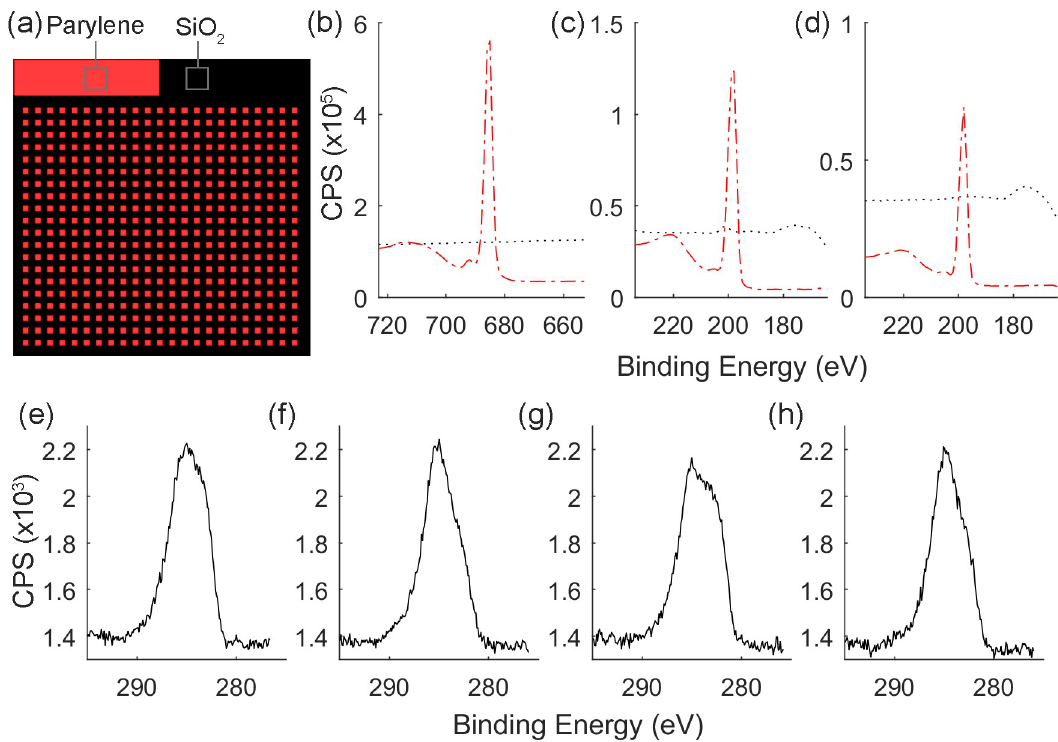
Fig 3. XPS analysis of parylene/SiO 2 substrates that were manufactured by femtosecond laser ablation. (a) Schematic of the parylene/SiO 2 substrates indicating the location of spectra collection. (b) Fluorine 1s spectra of parylene-HT (Red, dashed line), and ablated SiO 2 (Black, dotted line), (c) Chlorine 2p spectra of parylene-D (Red, dashed line), and ablated SiO 2 (Black, dotted line), (d) Chlorine 2p spectra of parylene-C (Red, dashed line), and ablated SiO 2 (Black, dotted line). (e, f, g, h) Carbon 1s spectra collected from ablated SiO 2 regions of (e) parylene-HT, (f) parylene-D, (g) parylene-C and (h) parylene-N